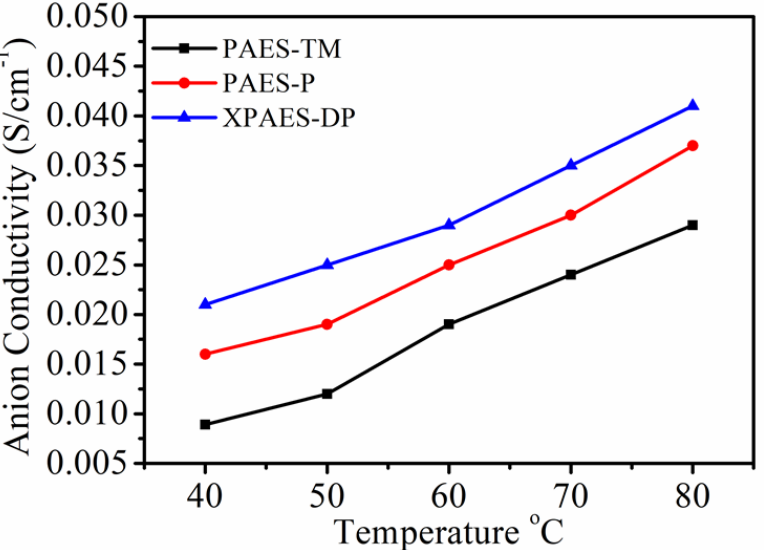
Figure 3. Anion conductivity as a function of temperature for different